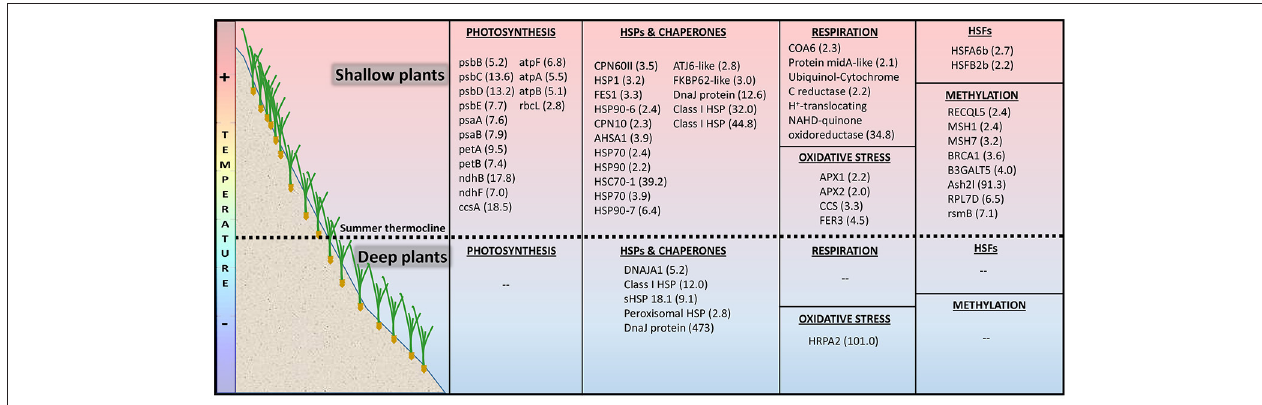
FIGURE 5 | Depth-specific heat transcriptomic response of Posidonia oceanica plants living above (shallow 5 m) and below (deep 25 m) the summer thermocline after being exposed to an increased temperature of 32 ◦ C during 5 days. The table shows differentially expressed genes (s-DEGs and DEGs) exclusively up-regulated in each of the two depths and their fold change in